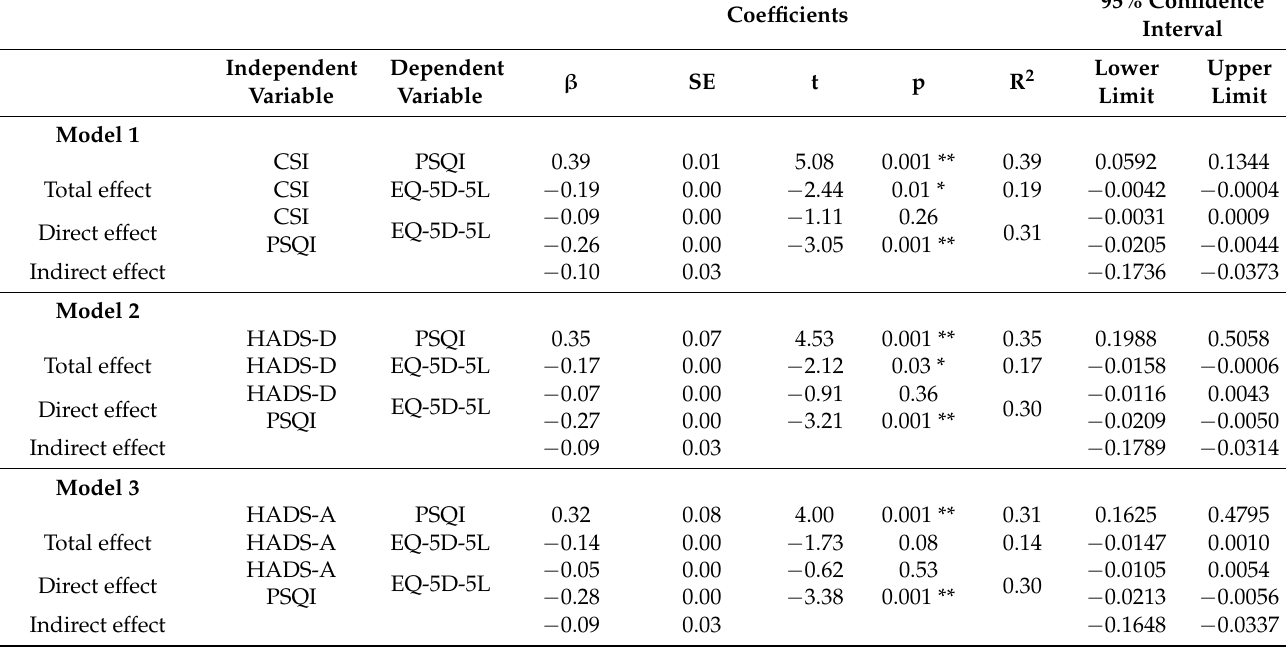
Table 2. Regression coefficients of mediation